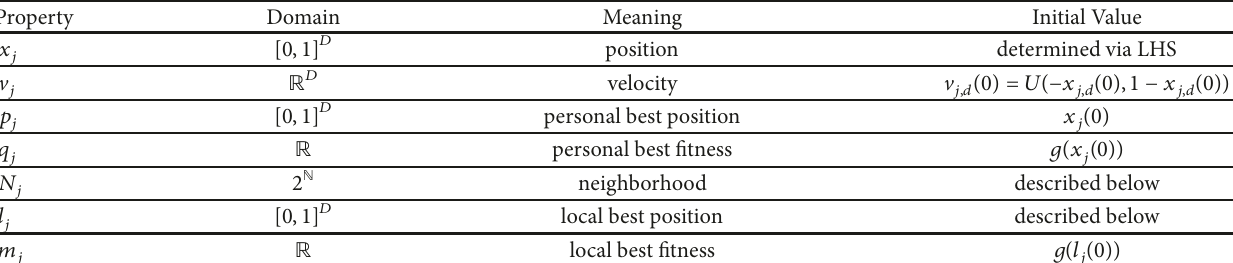
Table 1: Particle attributes indexed by position in